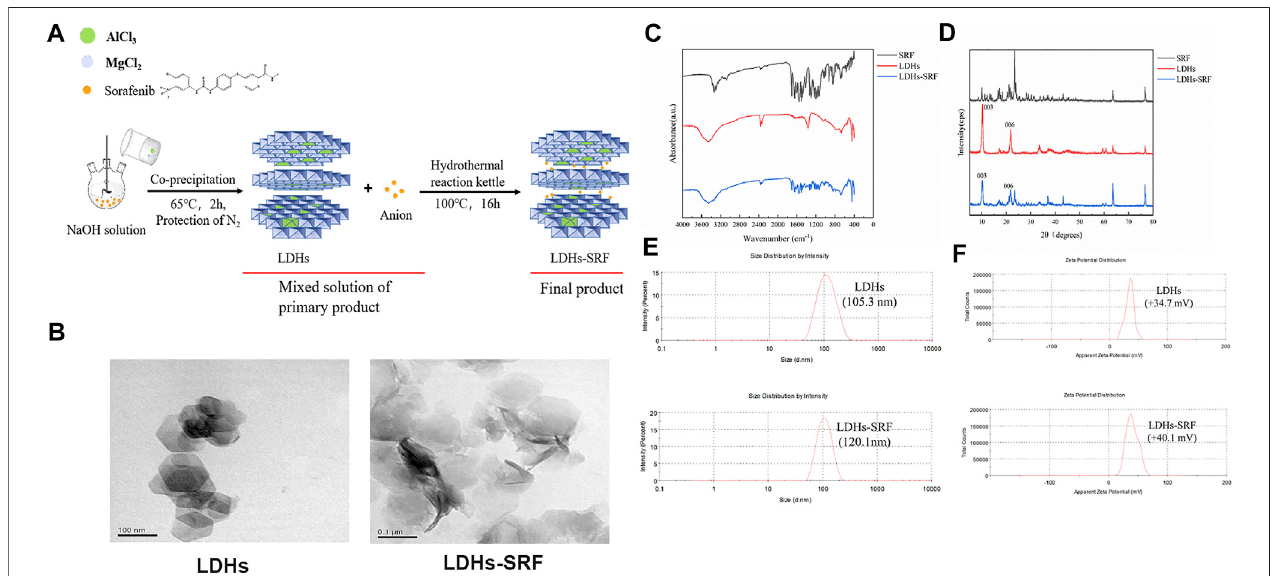
FIGURE 1 | The Characterization of LDHs and LDHs-SRF. (A) Schematic diagram of synthesis path of LDHs-SRF; (B) TEM image of LDHs and LDHs-SRF; The scalebarinTEMimages:100 nm. (C) FT-IRspectraofSRF,LDHsandLDHs-SRF; (D) XRDpatternsofSRF,LDHsandLDHs-SRF; (E) ThesizedistributionofLDHsand LDHs-SRF, PDI represent polymer dispersity index; (F) Zeta potential of LDHs and LDHs-SRF in